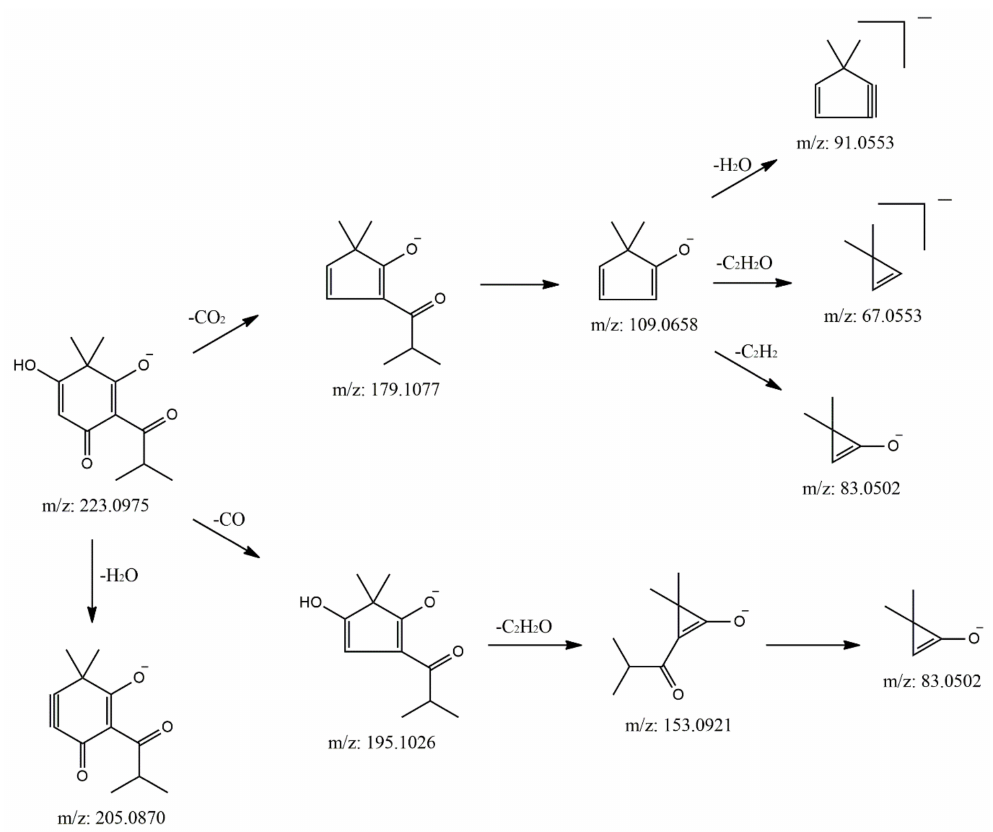
Figure 4. Proposed fragmentation scheme for 3 (cid:48) 3 (cid:48) me6 (cid:48) oxoPIB, [M-H] − = 223. The main fragments are shown together with information about their m / z values. The mass spectra with the peaks assignable to each fragment are reported in Figure